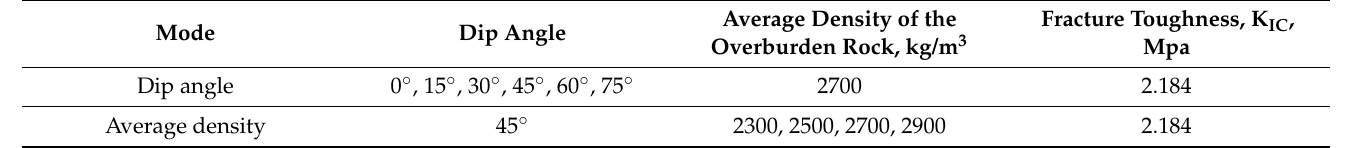
Table 1. Numerical parameters for numerical models.